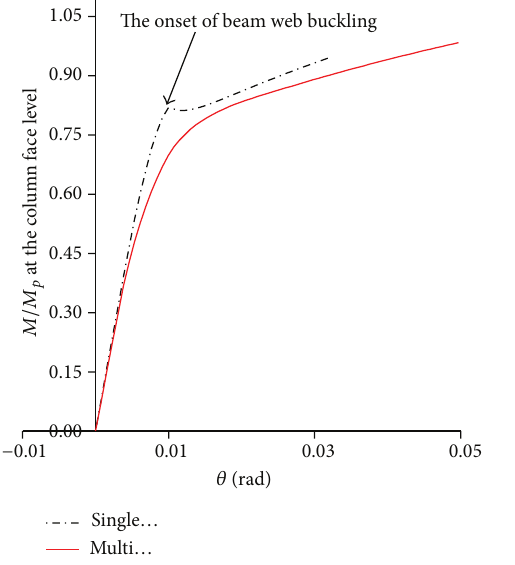
Figure 8: Normalize moment-rotation curves of modified speci- mens SAC7 with single and multilongitudinal